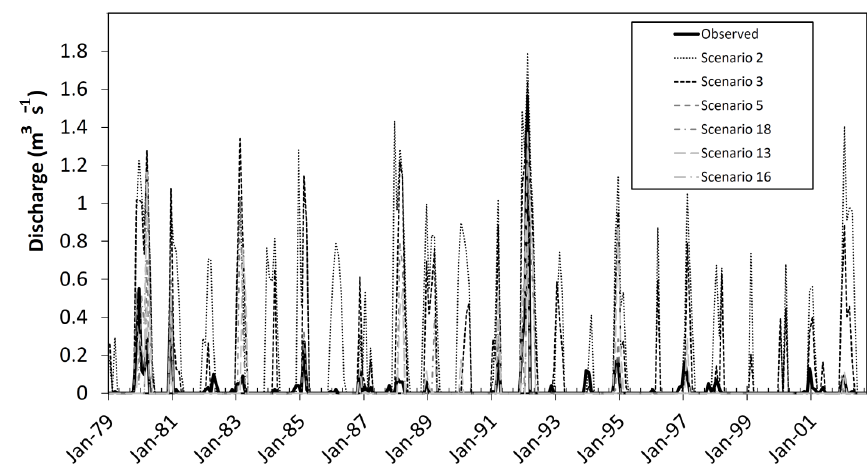
Figure 9. Simulated and observed average monthly discharge (m 3 s − 1 ) for scenarios 2, 3, 5, 18, 13 and